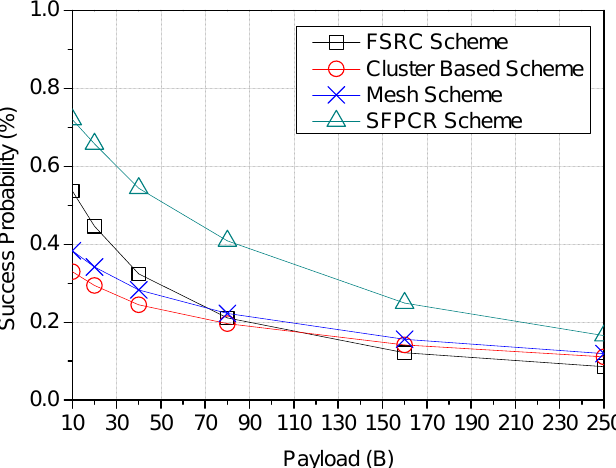
Figure 6. Plots variation in Success Probability according to the Payload Size (B) with a comparison between the SFPCR scheme and other protocols.